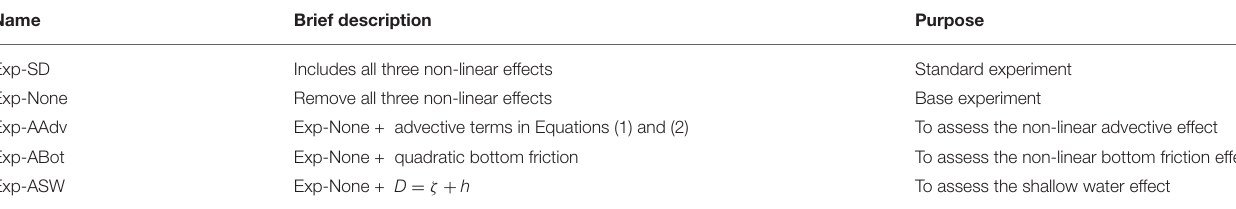
TABLE 3 | The new numerical approach used to study the mechanisms of tide-surge